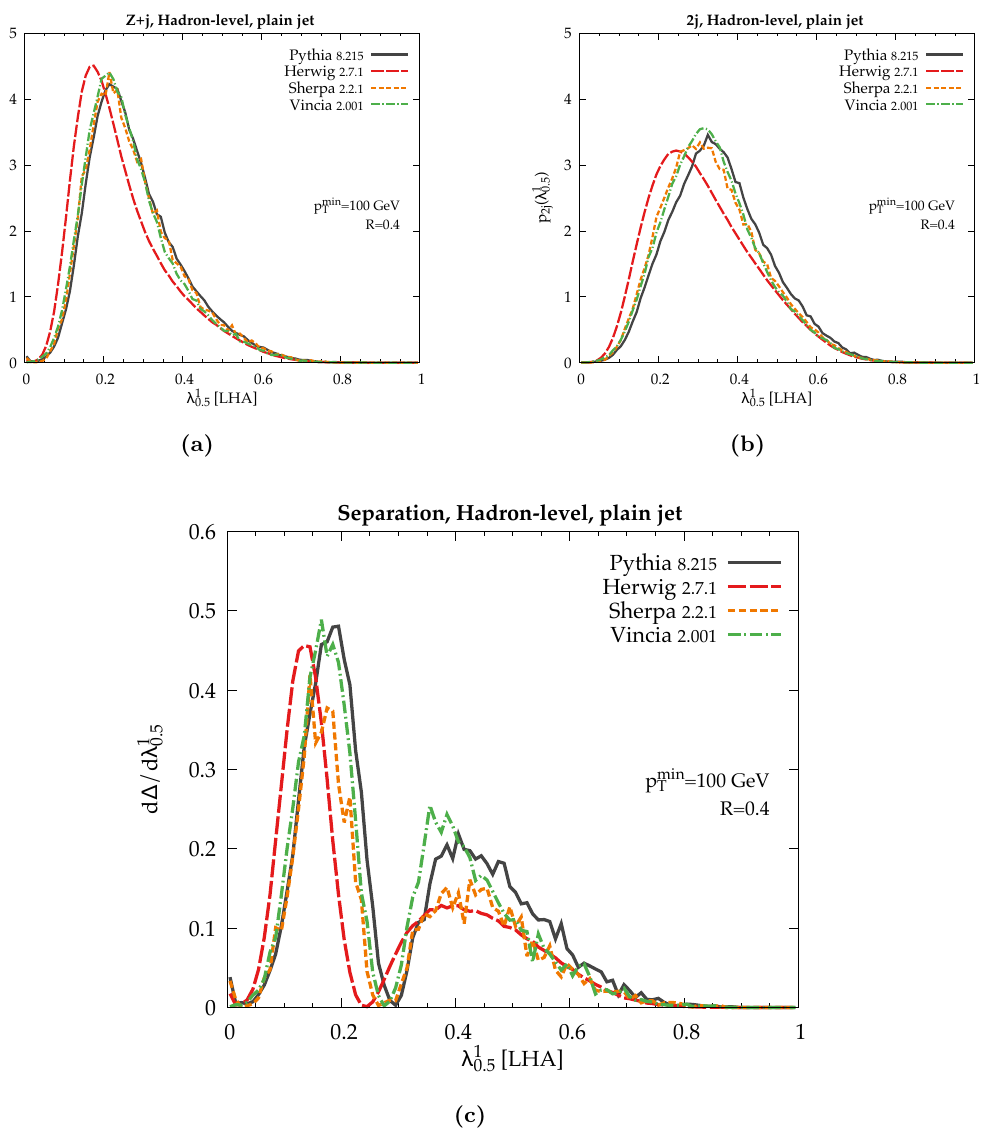
Figure 17. Distributions of the LHA at the LHC for (a) the pp Z + j (\quark-enriched") ! sample, (b) the pp 2 j (\gluon-enriched") sample, and (c) the classi(cid:12)er separation integrand in ! eq. (3.18). Four parton-shower generators | Pythia 8.215 , Herwig 2.7.1 , Sherpa 2.2.1 , and Vincia 2.001 | are run at their baseline settings with p min = 100 GeV and jet radius R = 0 : T